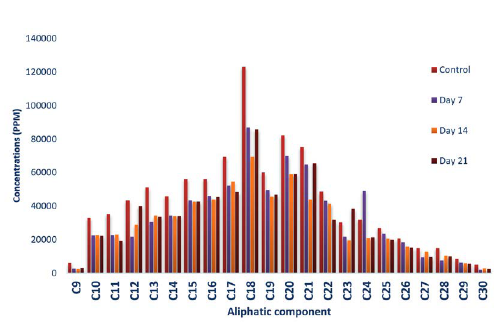
Fig. 3. Concentrations of Aliphatic compounds in residual crude oil from Pseudomonas aeruginosa culture fluid.